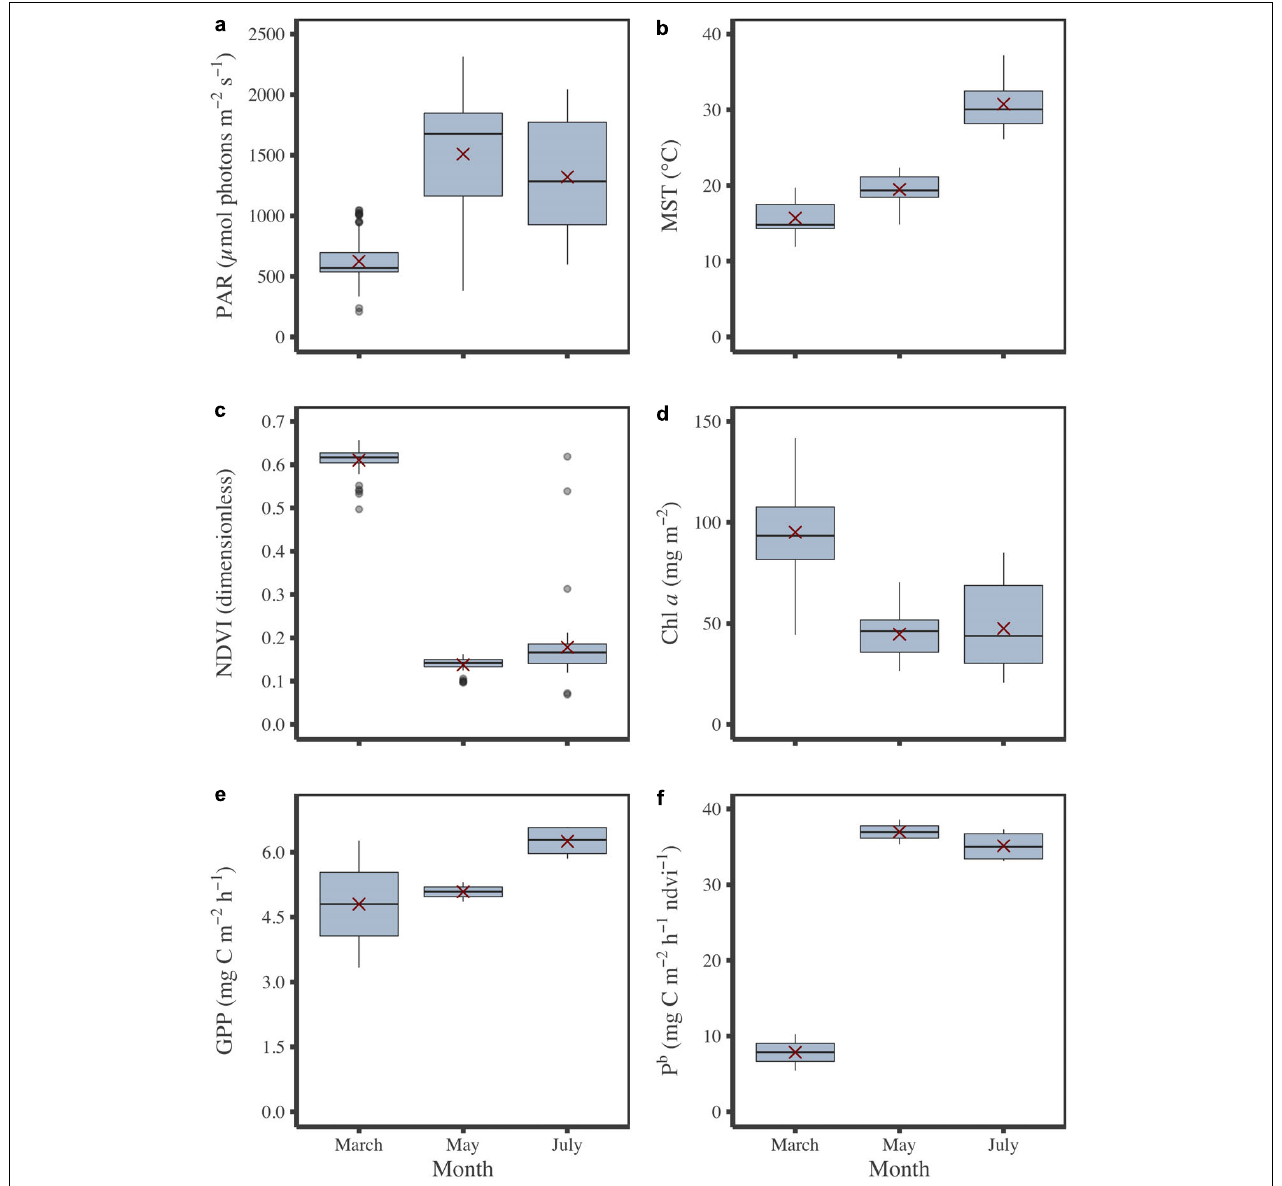
FIGURE 4 | Monthly variations of environmental and MPB parameters measured in situ . PAR (a) , MST (b) , biomass in NDVI (c) and Chl a content (d) , GPP (e) and P b (f) . Red crosses correspond the mean values for the corresponding